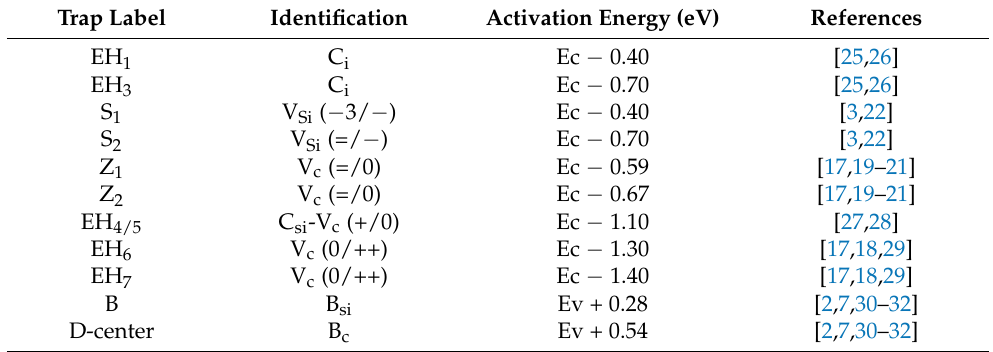
Table 1. Details on the majority and minority charge carrier traps in n-type 4H-SiC materials. Trap